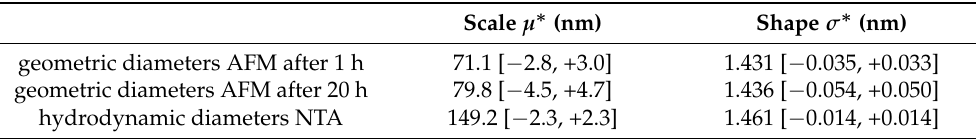
Figure 5. Log-normal distributions fitted to geometric diameter histograms from AFM ( A ) and to hydrodynamic diameter histograms from NTA ( B ). Table 1. Parameters of log-normal distribution fitted to geometric and hydrodynamic diameters with its 95% CI estimated from